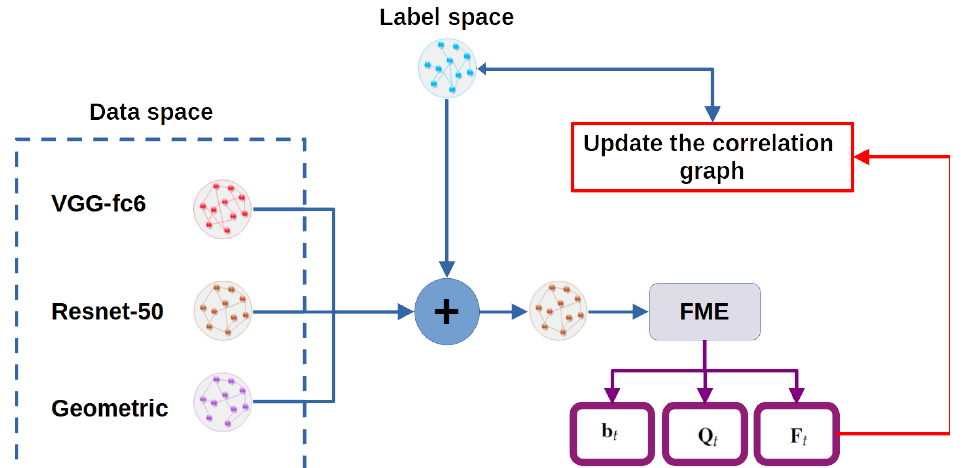
Figure 2. The framework of the proposed method. Different similarity graphs corresponding to the different descriptors are constructed. The correlation graph is constructed in the score space. All graphs are merged into a single graph. The FME method is repeatedly used to process the resulting fused graph and to refine the face beauty prediction for the unseen images in each iteration.